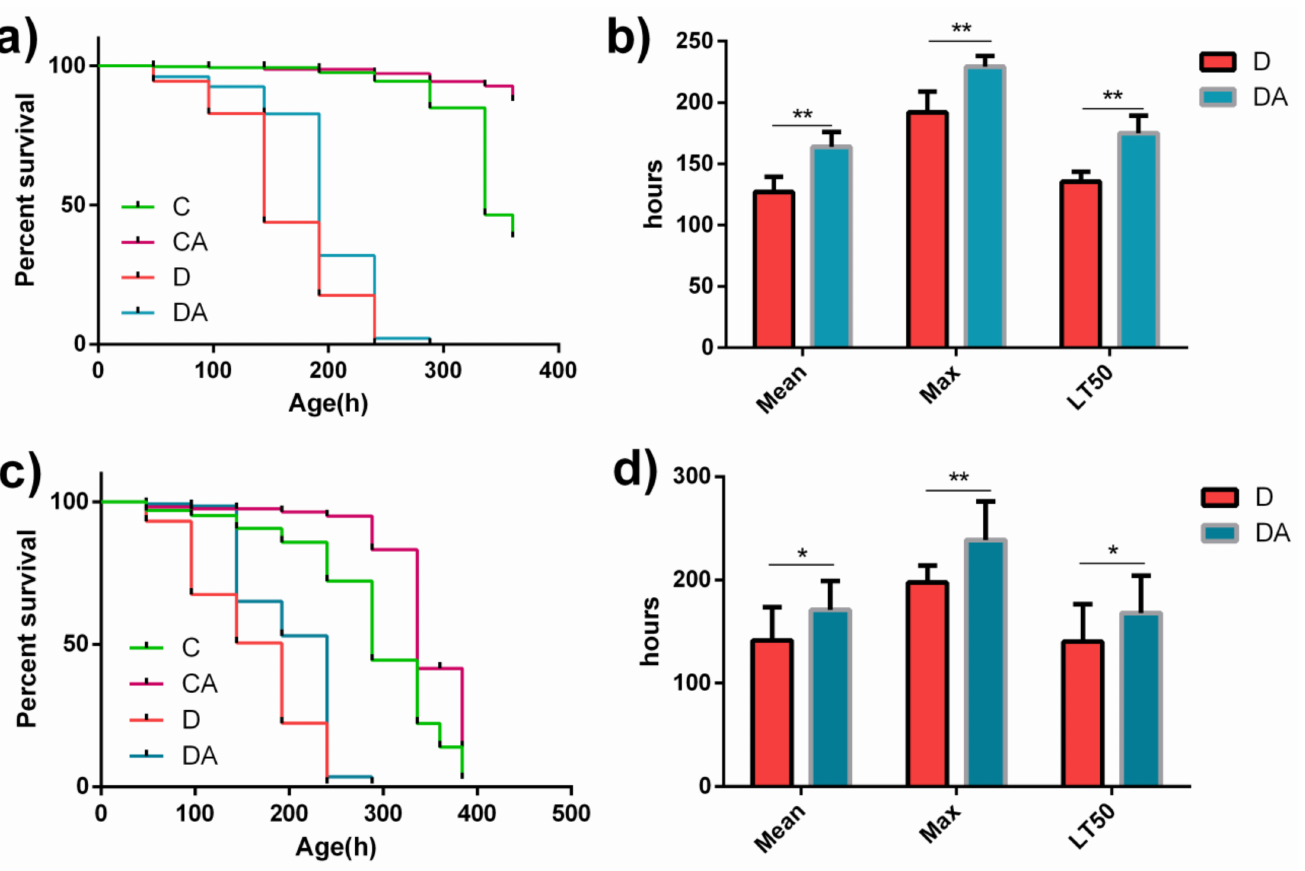
Figure 1. Effects of the dietary inclusion of BANCs on the lifespans of female D. melanogaster with DSS-induced inflammation. C, CA, D, and DA represent the blank control group, BANC control group, inflamed group, and BANCs + inflamed group, respectively. Normal ( a ) or axenic ( c ) female D. melanogaster were fed 5% sucrose (C), 5% sucrose containing 0.1 mg/mL BANCs (CA), 5% sucrose containing 7% DSS (D), or 5% sucrose containing 7% DSS and 0.1 mg/mL BANCs (DA). The mean, maximum (max), and median lethal time (LT50) of normal ( b ) and axenic ( d ) female D. melanogaster in the D and DA groups were measured. Data from triplicate repetitions are expressed as the means ± SEMs. Statistical significance: * p < 0.05, ** p <